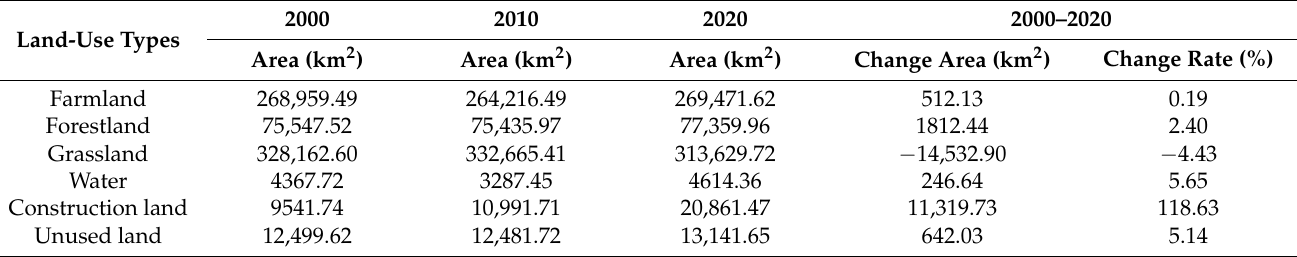
Table 5. Dynamic changes in land-use types during 2000–2020 in the AENC.